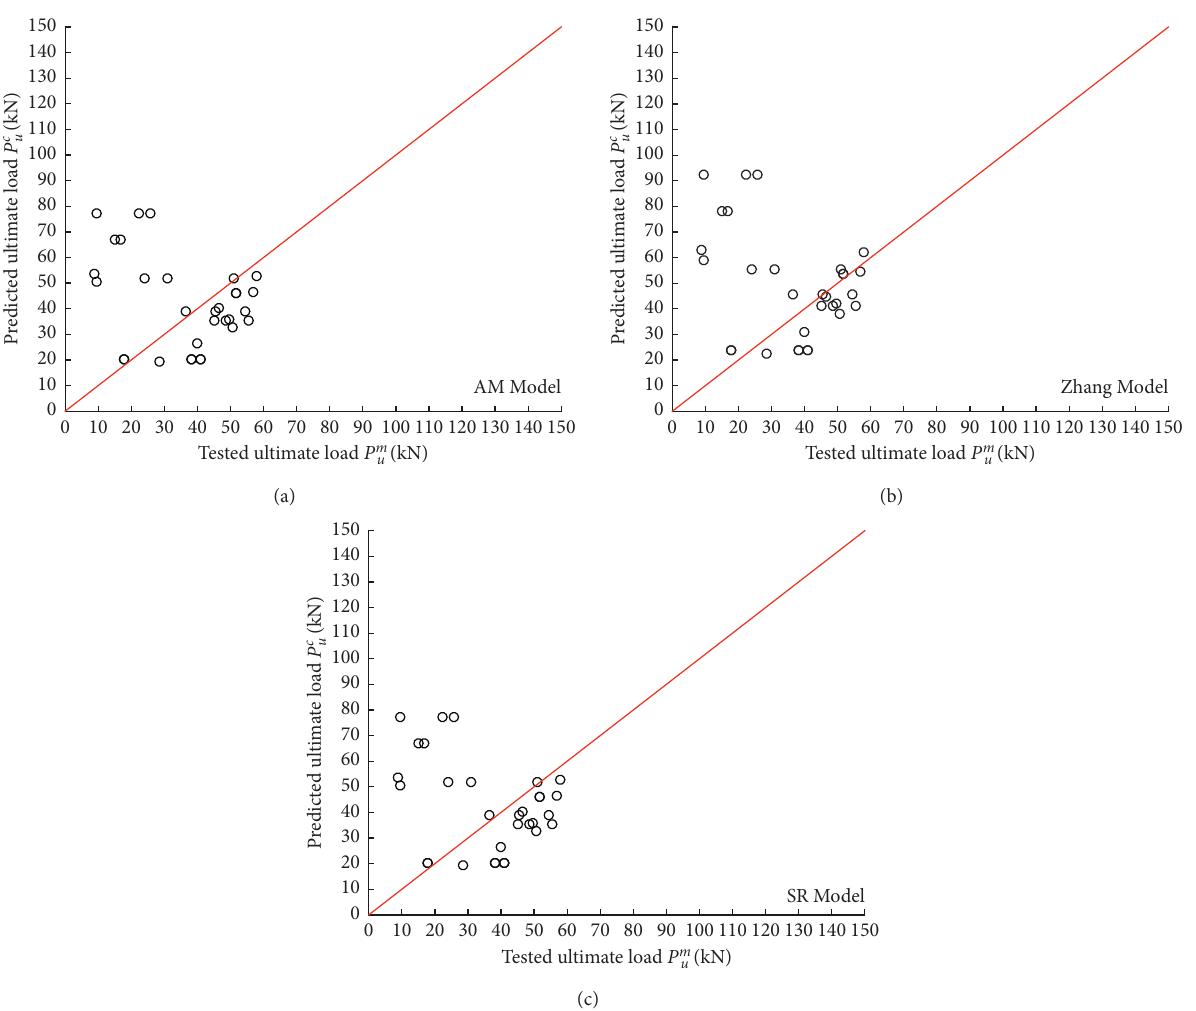
Figure 2: Comparison between the calculated value and the experimental value for the three models under the adhesive-FRP interface failure mode: (a) AM Model, (b) Zhang Model, and (c) SR